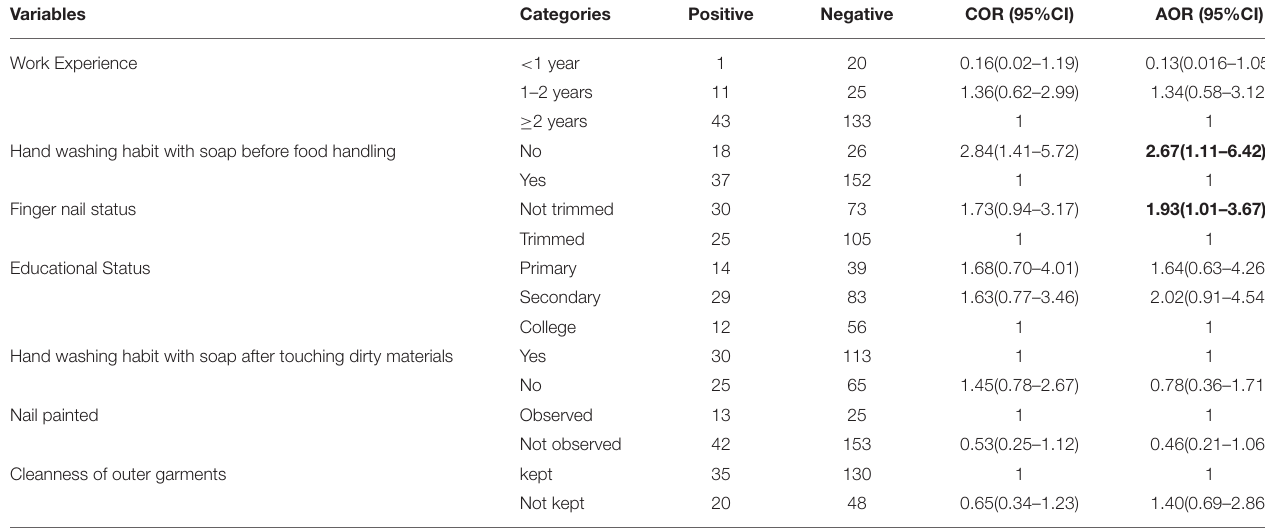
TABLE 5 | Factors associated with IPIs among food handlers worked in students’ caterings of WSU, Wolaita Sodo, South Ethiopia from January 10 to February 10, 2016.